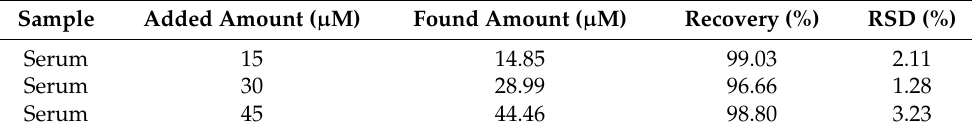
Table 3. Results for the determination of DA in human serum samples (n = 3) 1